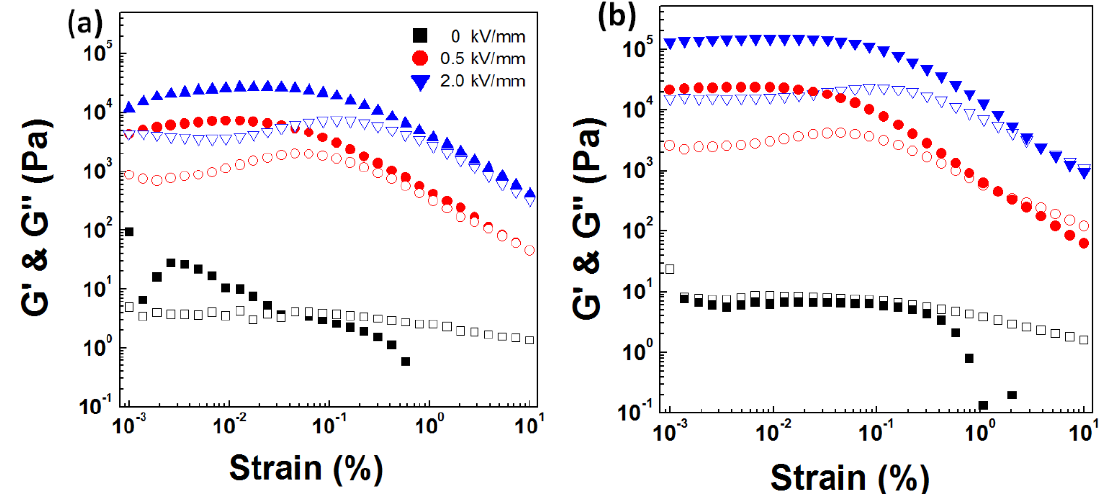
Figure 4. Strain amplitude sweep of the ER fluids at different electric field strengths: ( a ) pristine cellulose; ( b ) urea-terminated silane-modified cellulose (G ′ : closed symbol; G ″ : open symbol).